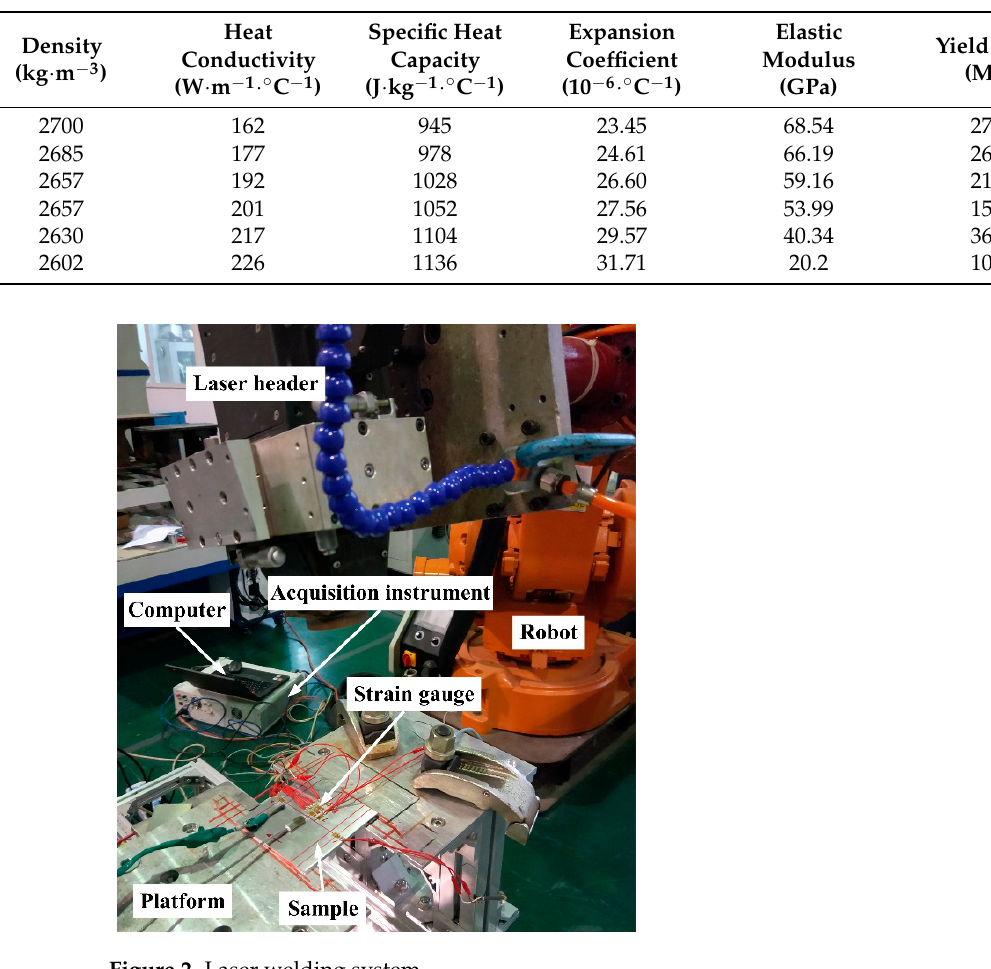
Table 2. Temperature-dependent properties of aluminum alloy 6061 [27].